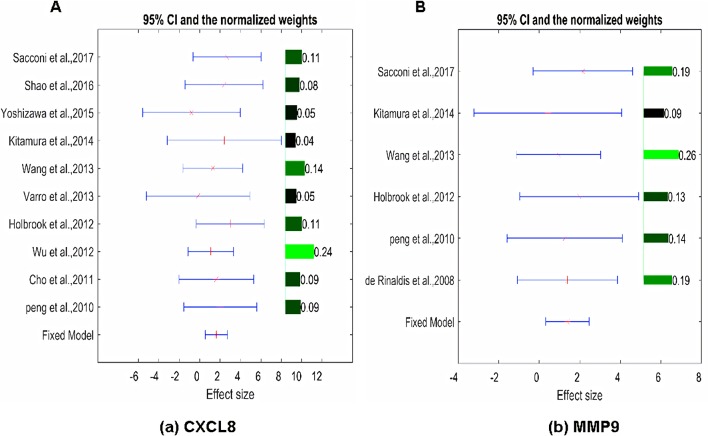
Effect size, 95% confidence interval, and weights for the genes (A) CXCL8 and (B) MMP9 from the meta-analysis results. The bar plot on the right of each figure represents the normalized weights for each dataset/study, which ranged between 0 and 1; the brighter (green) the color, the larger the weight (labeled right next to the bar). The star (in red) and lines (in blue) on the left are the mean of effect size (log fold change) and 95% confidence interval (CI) of each dataset/study, respectively.